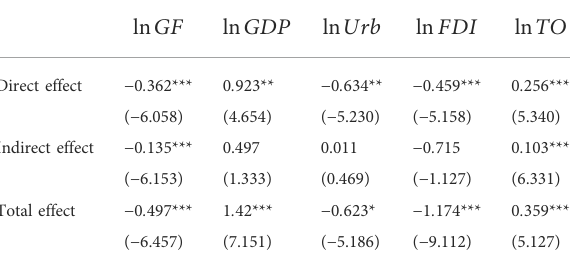
TABLE 6 Robustness